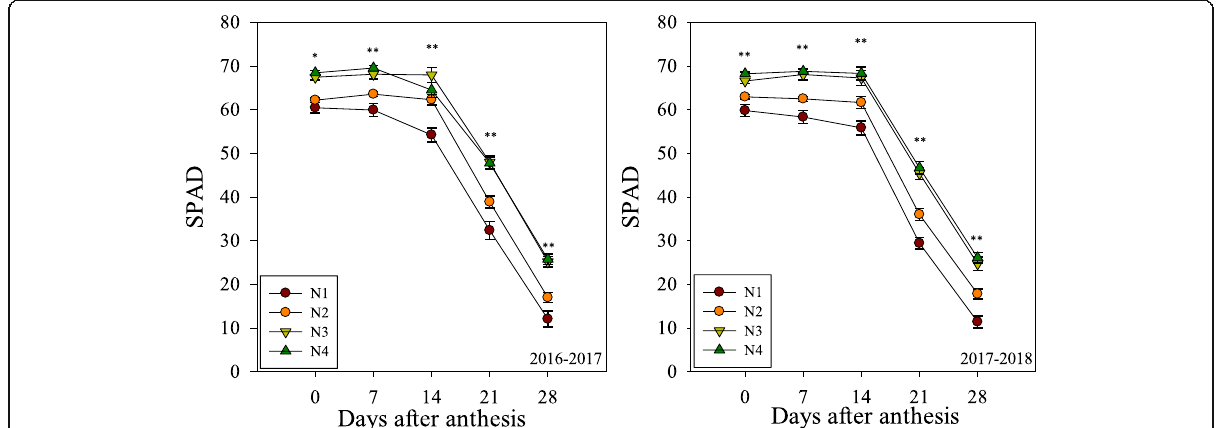
Fig. 2 Effects of four split nitrogen fertilizer treatments on flag leaf SPAD value at 0 days, 7 days, 14 days, 21 days, and 28 days after anthesis. ** P < 0.01; * P <